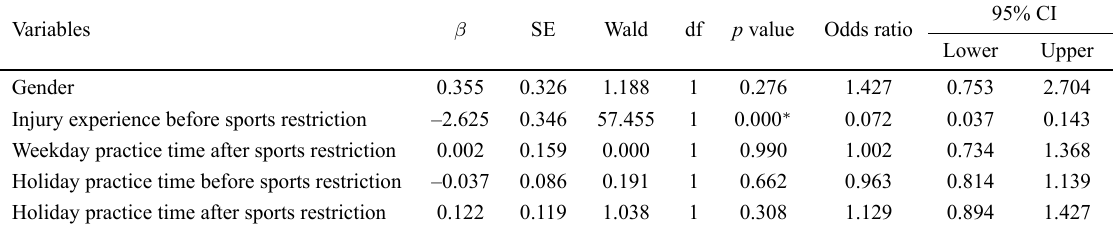
Table 2. Multiple logistic